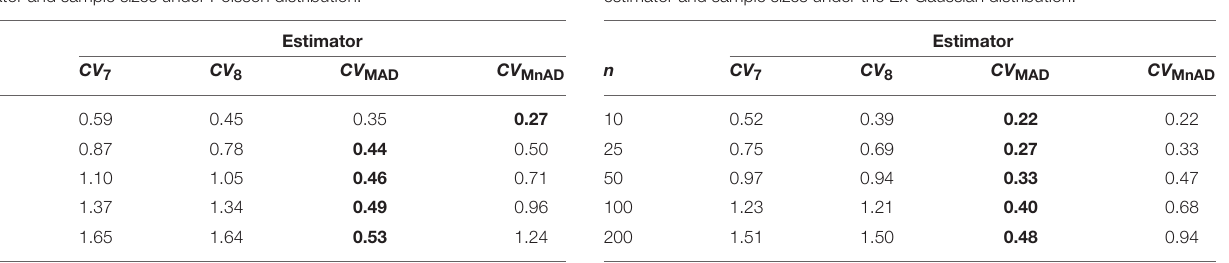
TABLE 8 | Median values of log 10 ( γ ) accuracy metric across θ produced for each estimator and sample sizes under the Ex-Gaussian